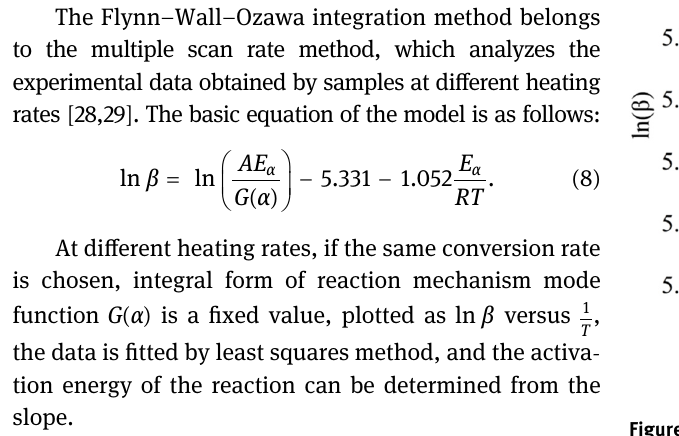
Figure 8: FWO method plots of sample K1 in di ff erent conversion